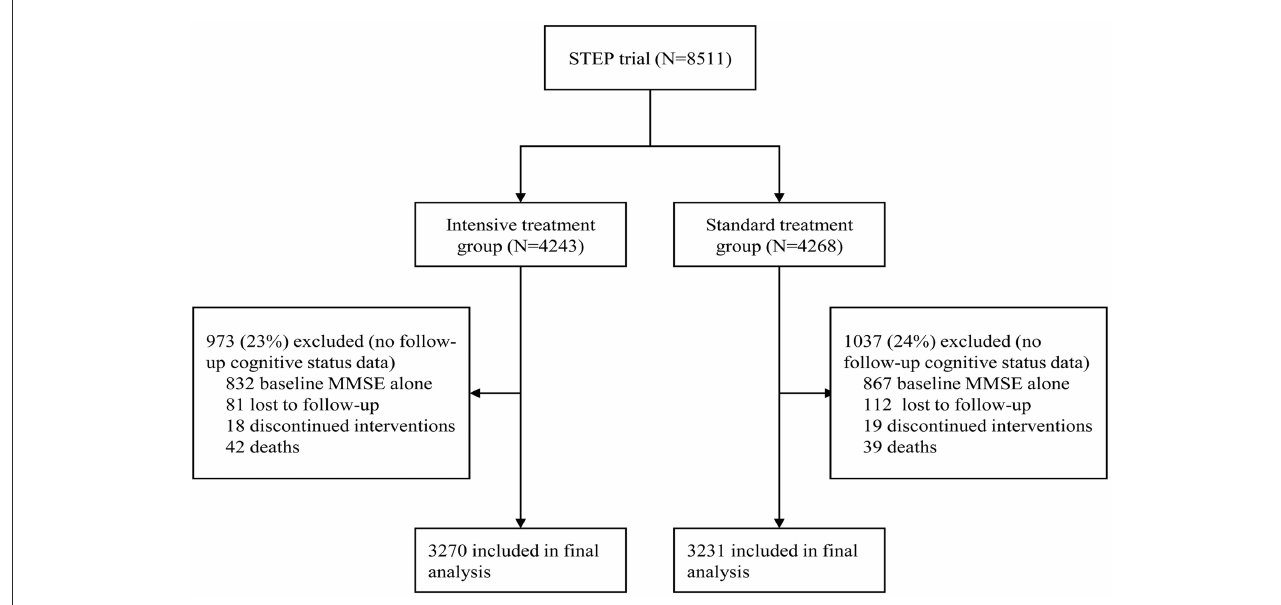
FIGURE1 Screening, randomization, and follow-up of participants in this cognitive function